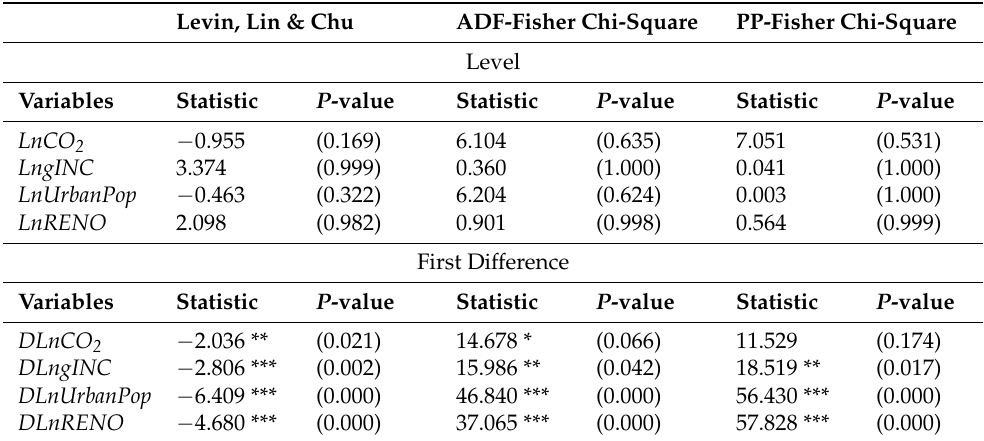
Table 4. Panel Unit Root Test.